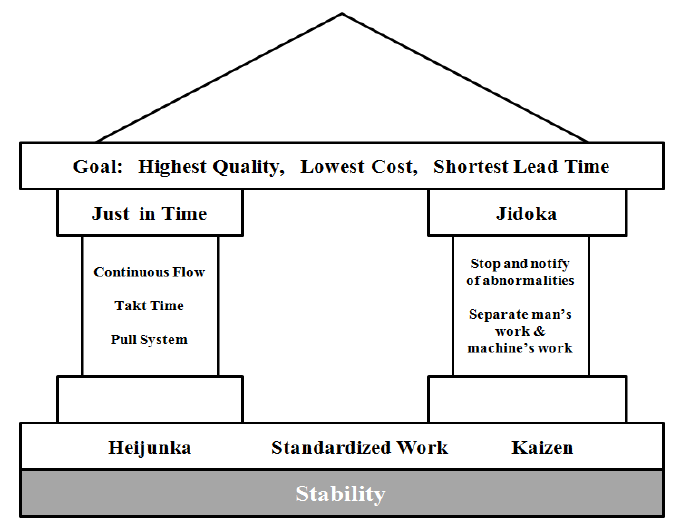
Figure 1. Toyota Production System House (Adapted from [32]).